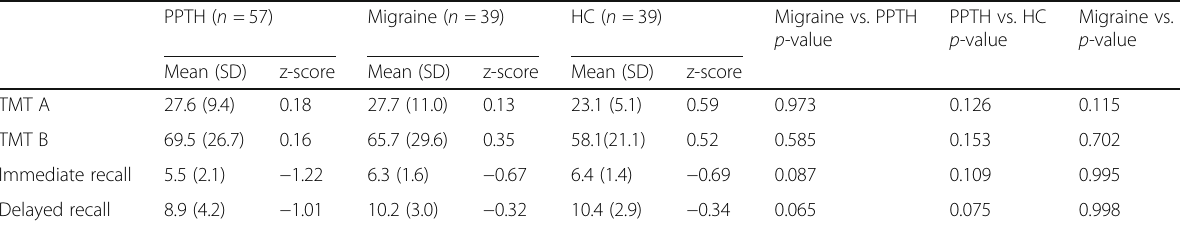
Table 2 Mean raw and z-scores for cognitive tests